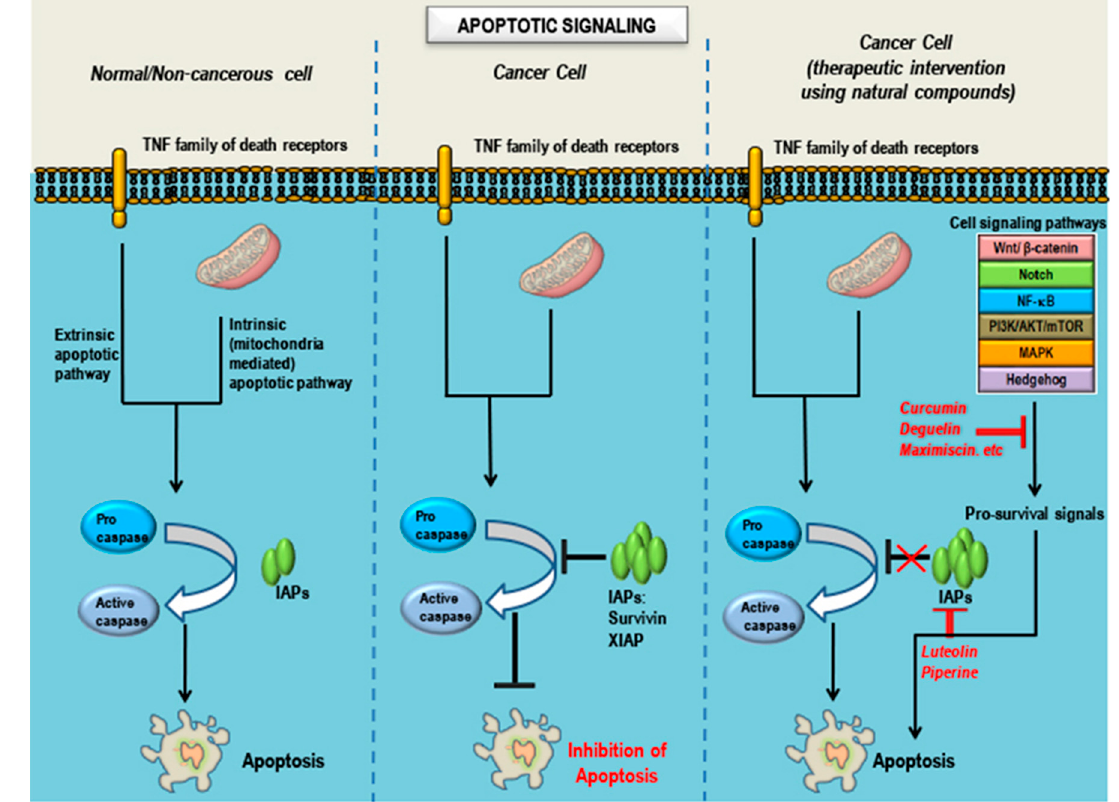
Figure 4. Natural compounds as pro-apoptotic agents in TNBCs: Mode(s) of Action. Apoptotic signaling in three different cell conditions. Apoptosis is regulated by several proteins including caspases, proteins that promote apoptosis such as Smac/Diablo/Bax/Bad (positive regulators), and proteins that inhibit apoptosis such as survivin/Bcl2/Bcl-xL/IAPs/XIAP (negative regulators). In a